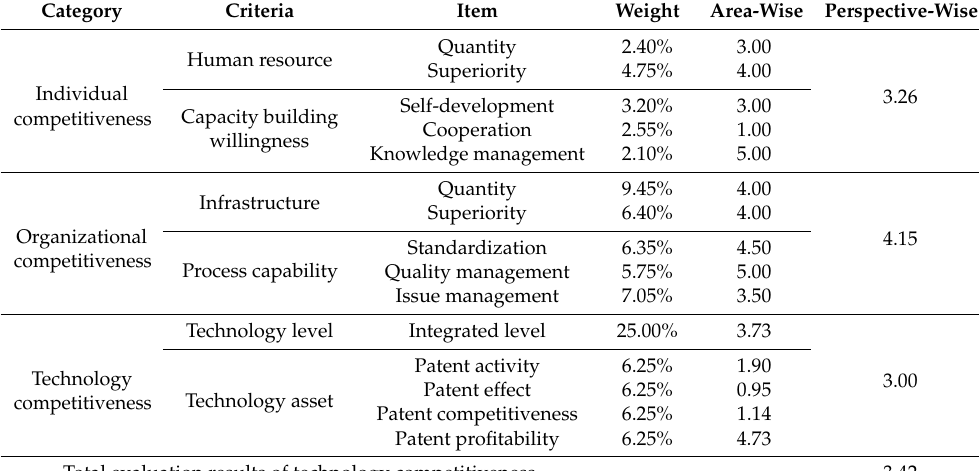
Table 12. Final evaluation results of internal technological